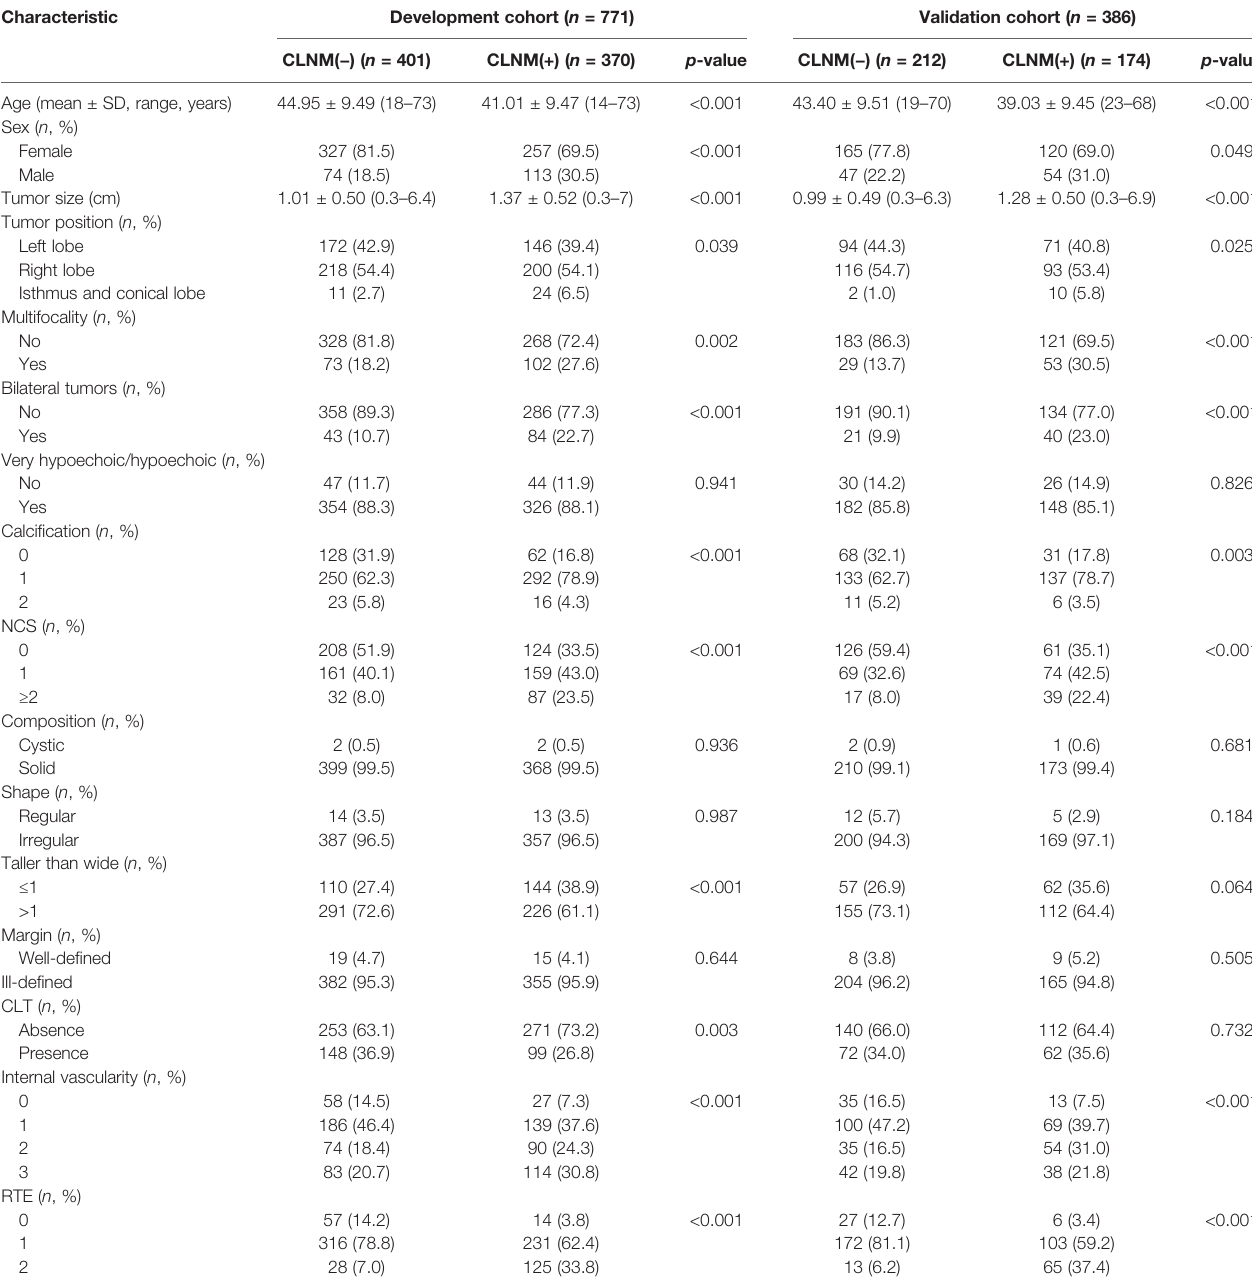
TABLE 1 | Clinical and US features of cN0 PTC in the development and validation cohorts.